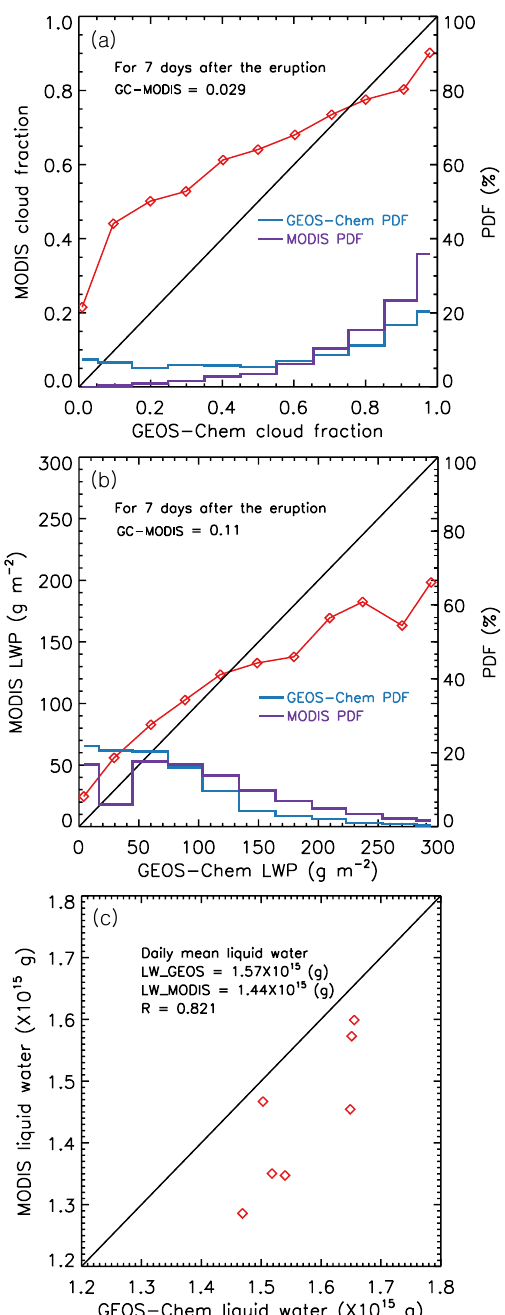
Fig. 4. Comparison (red line) of Cloud fraction (a) and LWP (b) de- rived from GEOS-Chem and MODIS during 7 days after the erup- tion over the region (30–70 ◦ N and 100–175 ◦ W). (c) comparison of daily total amount of liquid water derived from GEOS-Chem and MODIS for the same time period and region. Also shown in (a) and (b) are the probability density function (PDF, right y-axis) for each cloud fraction (or LWP) bin from GEOS-Chem (blue line) and MODIS (purple line). In each panel, the linear correlation coeffi- cient ( R ) and the average difference between GEOS-Chem (GC) and MODIS are also